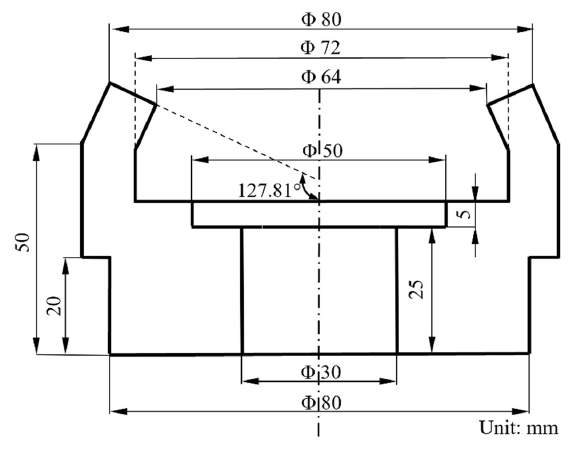
Figure 14. Detailed data about the workpiece.